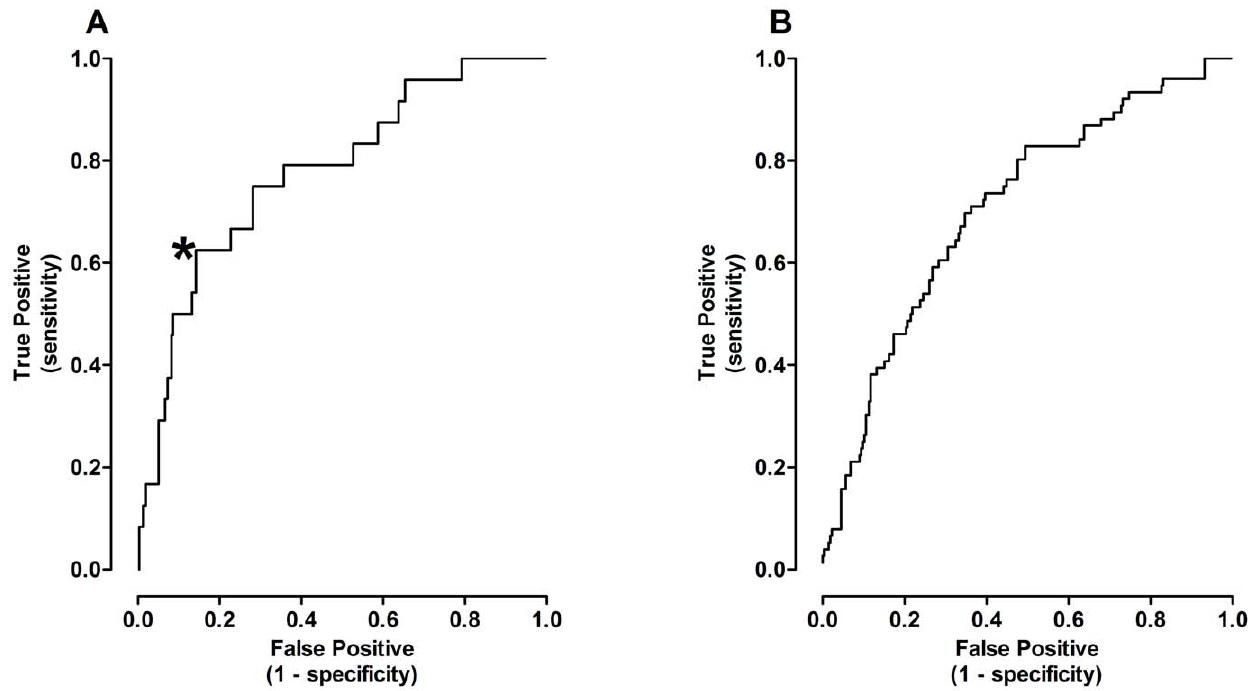
Figure 4. The receiver operating characteristics of a nominal logistical regression using DXA-derived body composition as independent variables to estimate the probability of DM2 or either DM2 or MS in the full DXA population (IG + CV) show that a large percentage of the diseased individuals can be identified without a high cost of a false positive diagnosis. A) The steep slope of the initial portion of the curve to the inflection point (*) indicates that a high proportion of individuals with DM2 can be identifying using DXA- derived FM and TF. Area under the curve is 0.78 with a standard error of 0.05 (24 subjects with DM2 and 327 without; p , 0.0001). The 95% confidence interval is 0.68 to 0.88. [Regression equation: risk of DM2=1/(1 + e 2 z ), where z=1.94 2 0.53(TF) + 0.28(FM).] B) Similarly, the ROC for the detection of either DM2 or MS also shows inflection points, consistent with sensitive detection of subjects with disease. The AUC is 0.71 6 0.03 (103 subjects with disease, 238 without; p , 0.0001). The 95% confidence interval for the AUC is 0.64 to 0.77. [Regression equation: k=2.32 2 0.24(TF) +